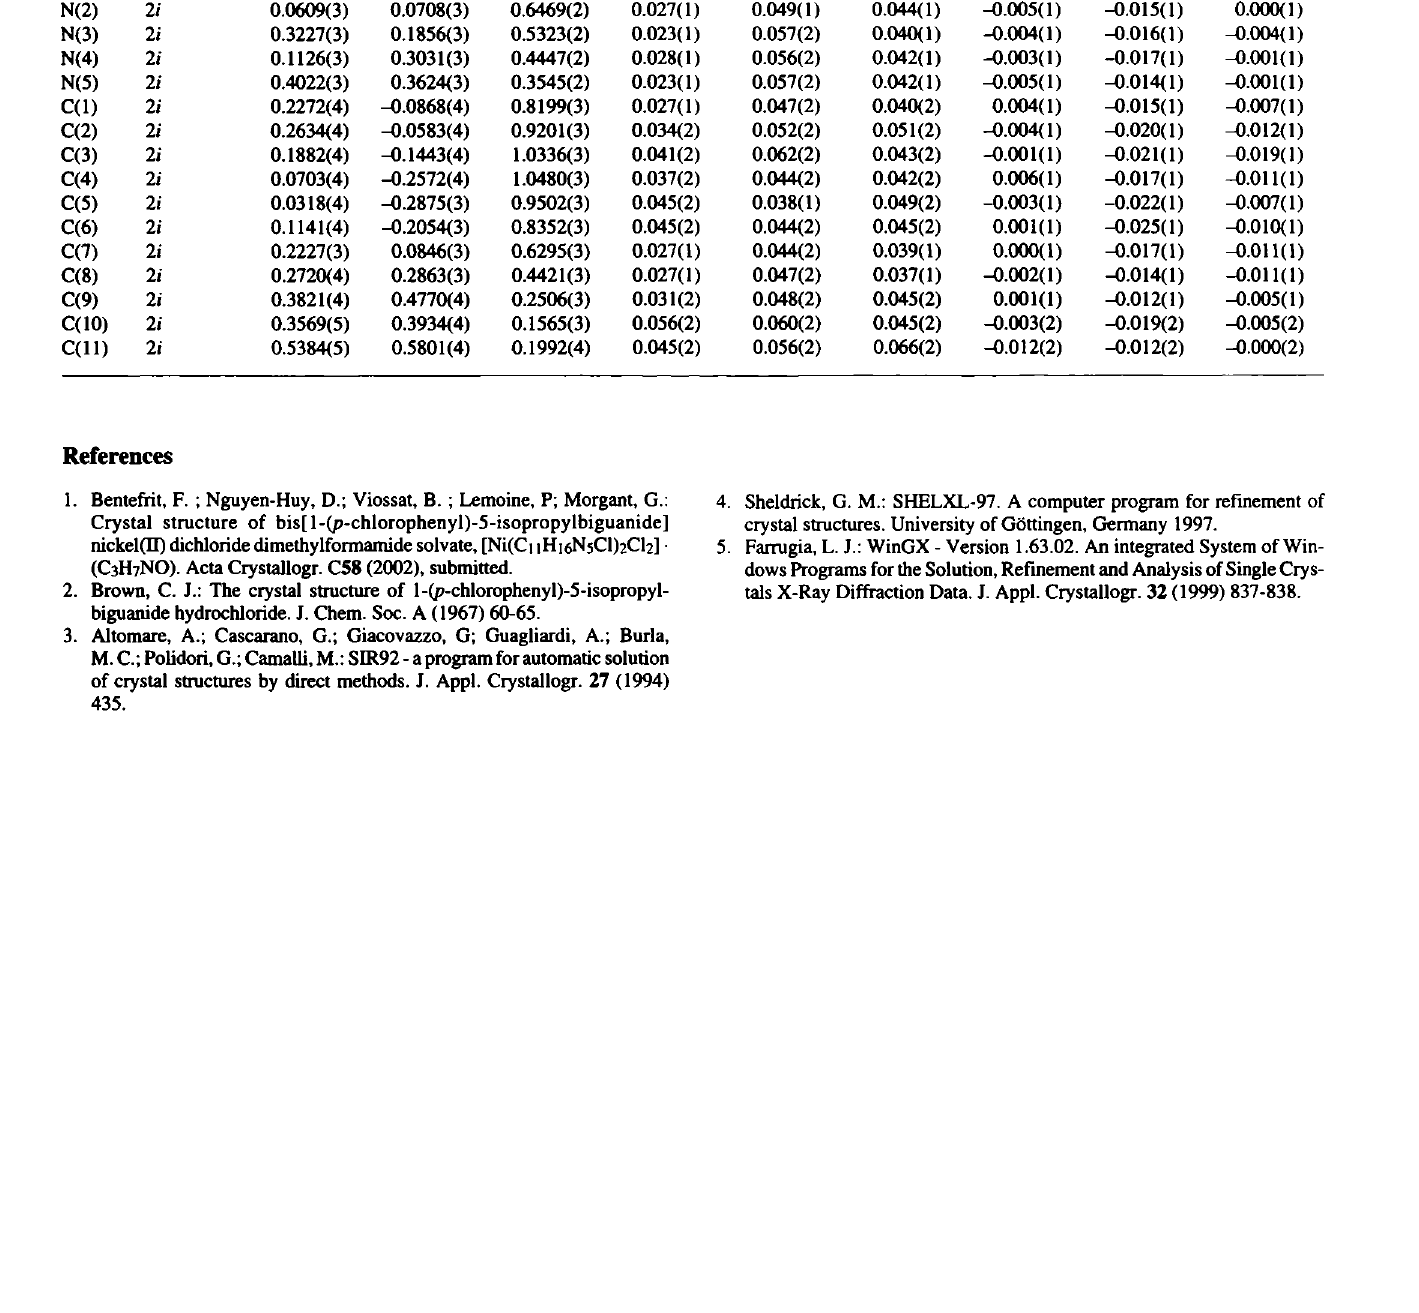
Table 3. Atomic coordinates and displacement parameters (in À 2